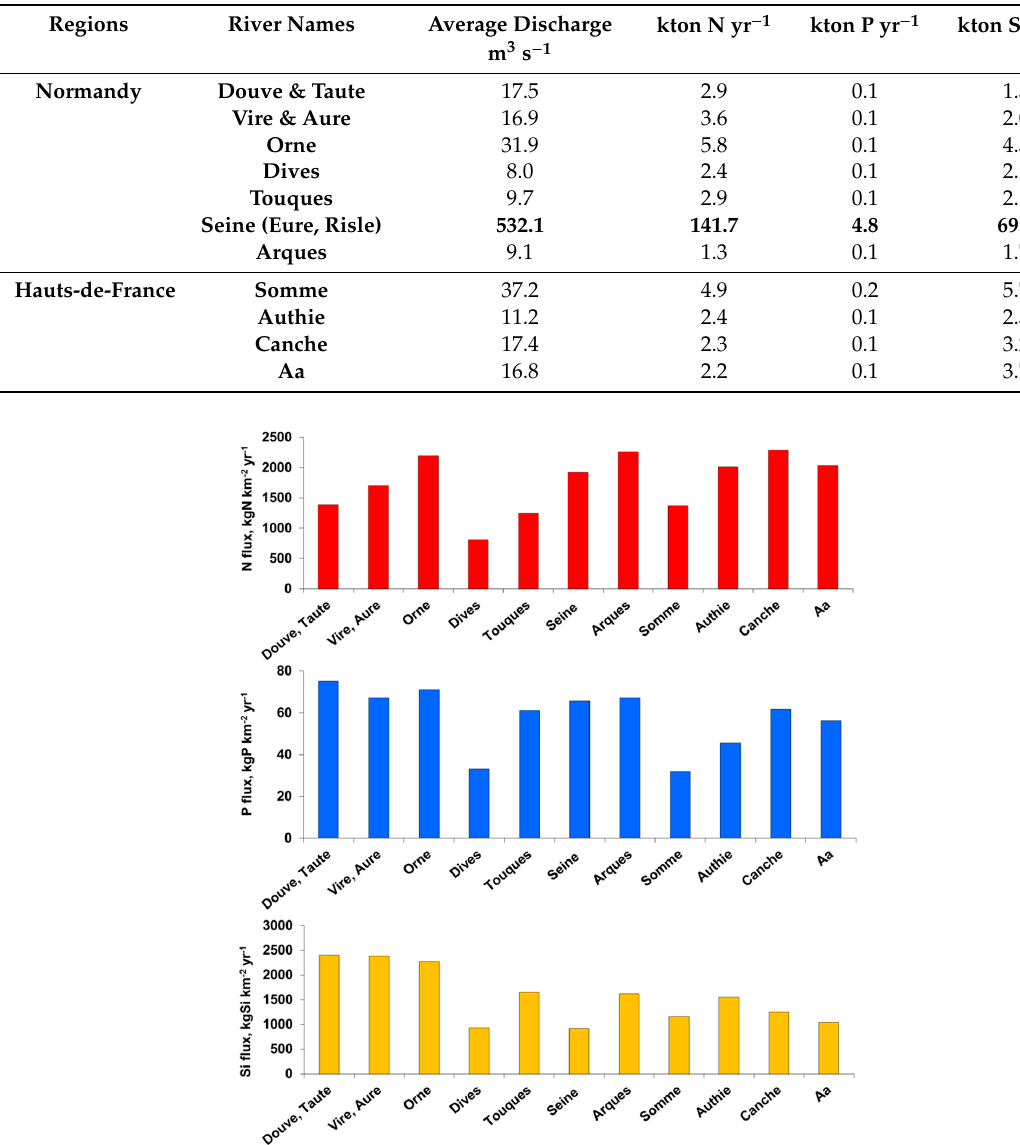
Figure 4. Specific nutrient fluxes at the outlets of the rivers studied and averaged for the reference period, 2002–2014 (total N, P, and Si in kg km − 2 y − 1 ).